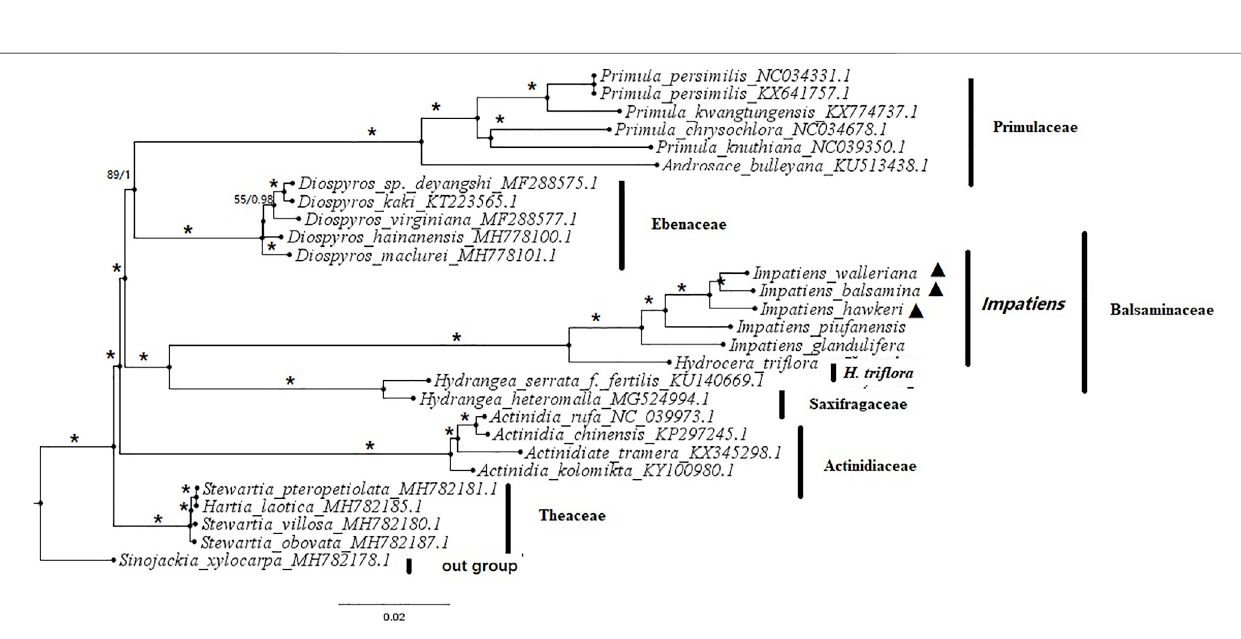
Frontiers in Genetics |